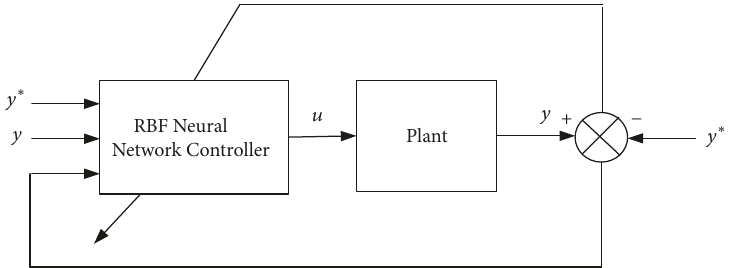
Figure 1: Radial basis function neurosliding mode controller